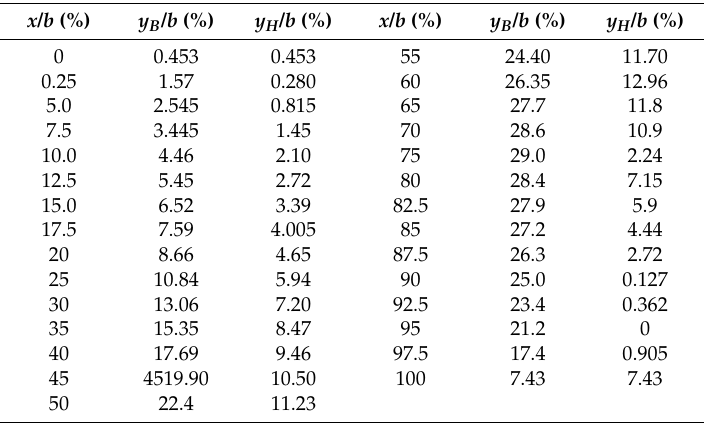
Table 1. Relative coordinates for the TC-4P blade